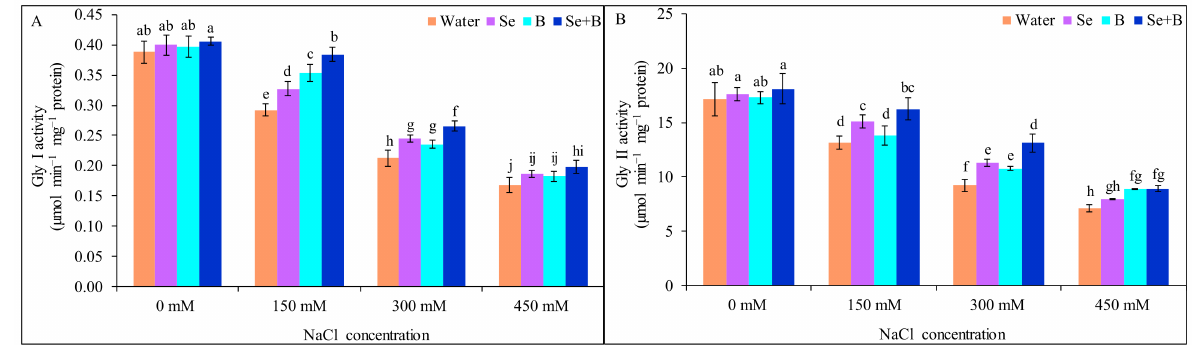
Figure 5. Effect of exogenous Se, B and Se+B on glyoxalase system: Gly I activity ( A ) and Gly II activity ( B ) in soybean at 0, 150, 300 and 450 mM NaCl-induced salt stress. Here, Se, B and Se+B indicate 50 µ M Na 2 SeO 4 , 1 mM H 3 BO 3 and 50 µ M Na 2 SeO 4 + 1 mM H 3 BO 3 , respectively. Values in a column with different letters are significantly different at p ≤ 0.05 applying Fisher’s LSD